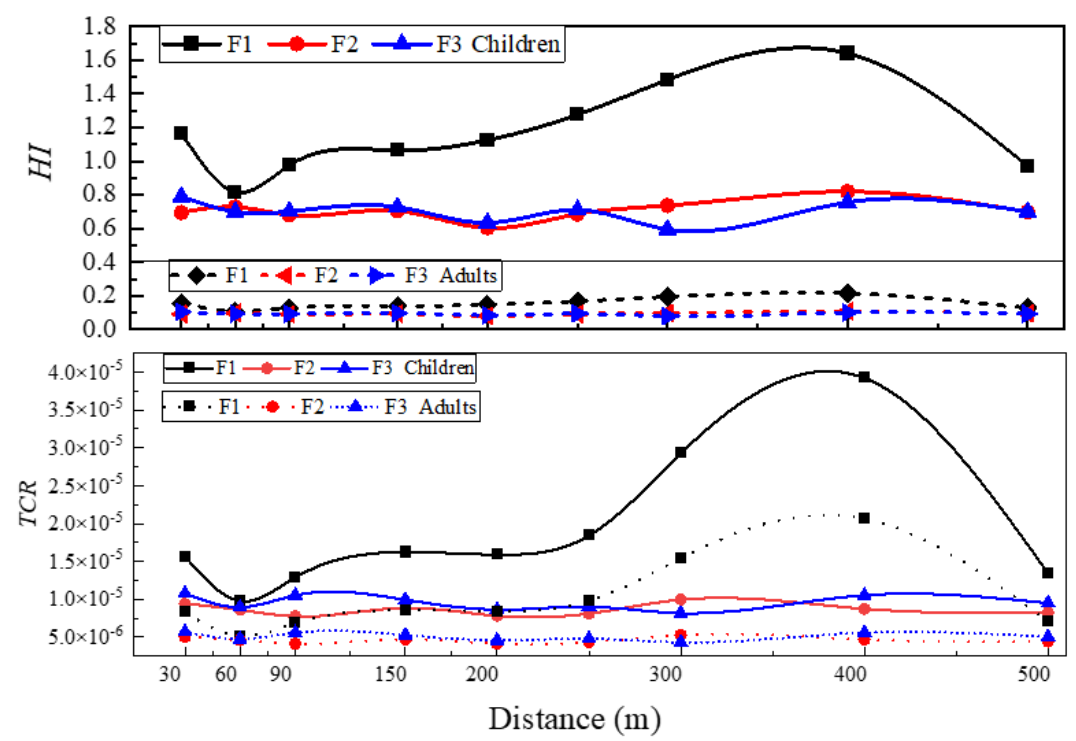
Figure 5. Spatial distribution of non-carcinogenic and carcinogenic risks for the three factories.